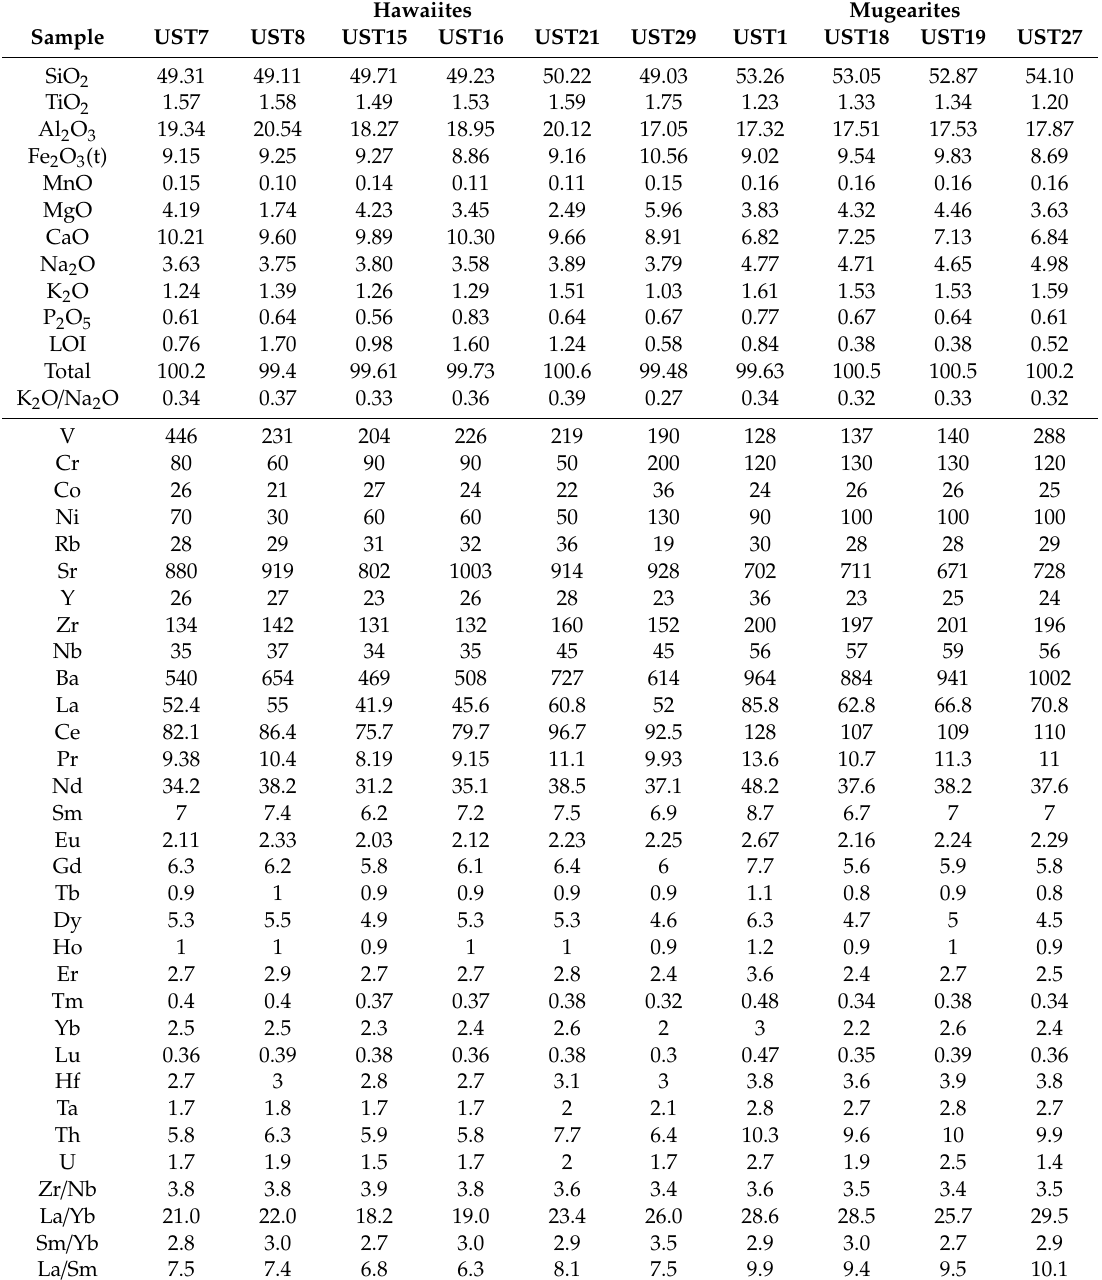
Table 3. Major (wt%) and trace elements (ppm) contents of the investigated millstones—hawaiites and mugearites of the Na-Alkaline